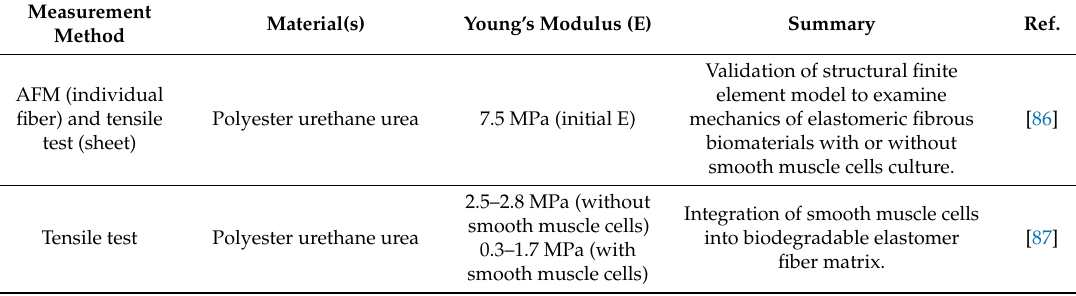
Table 1. Various ranges of the Young’s modulus of electrospun sca ff olds used in the cardiac tissue and regenerative engineering